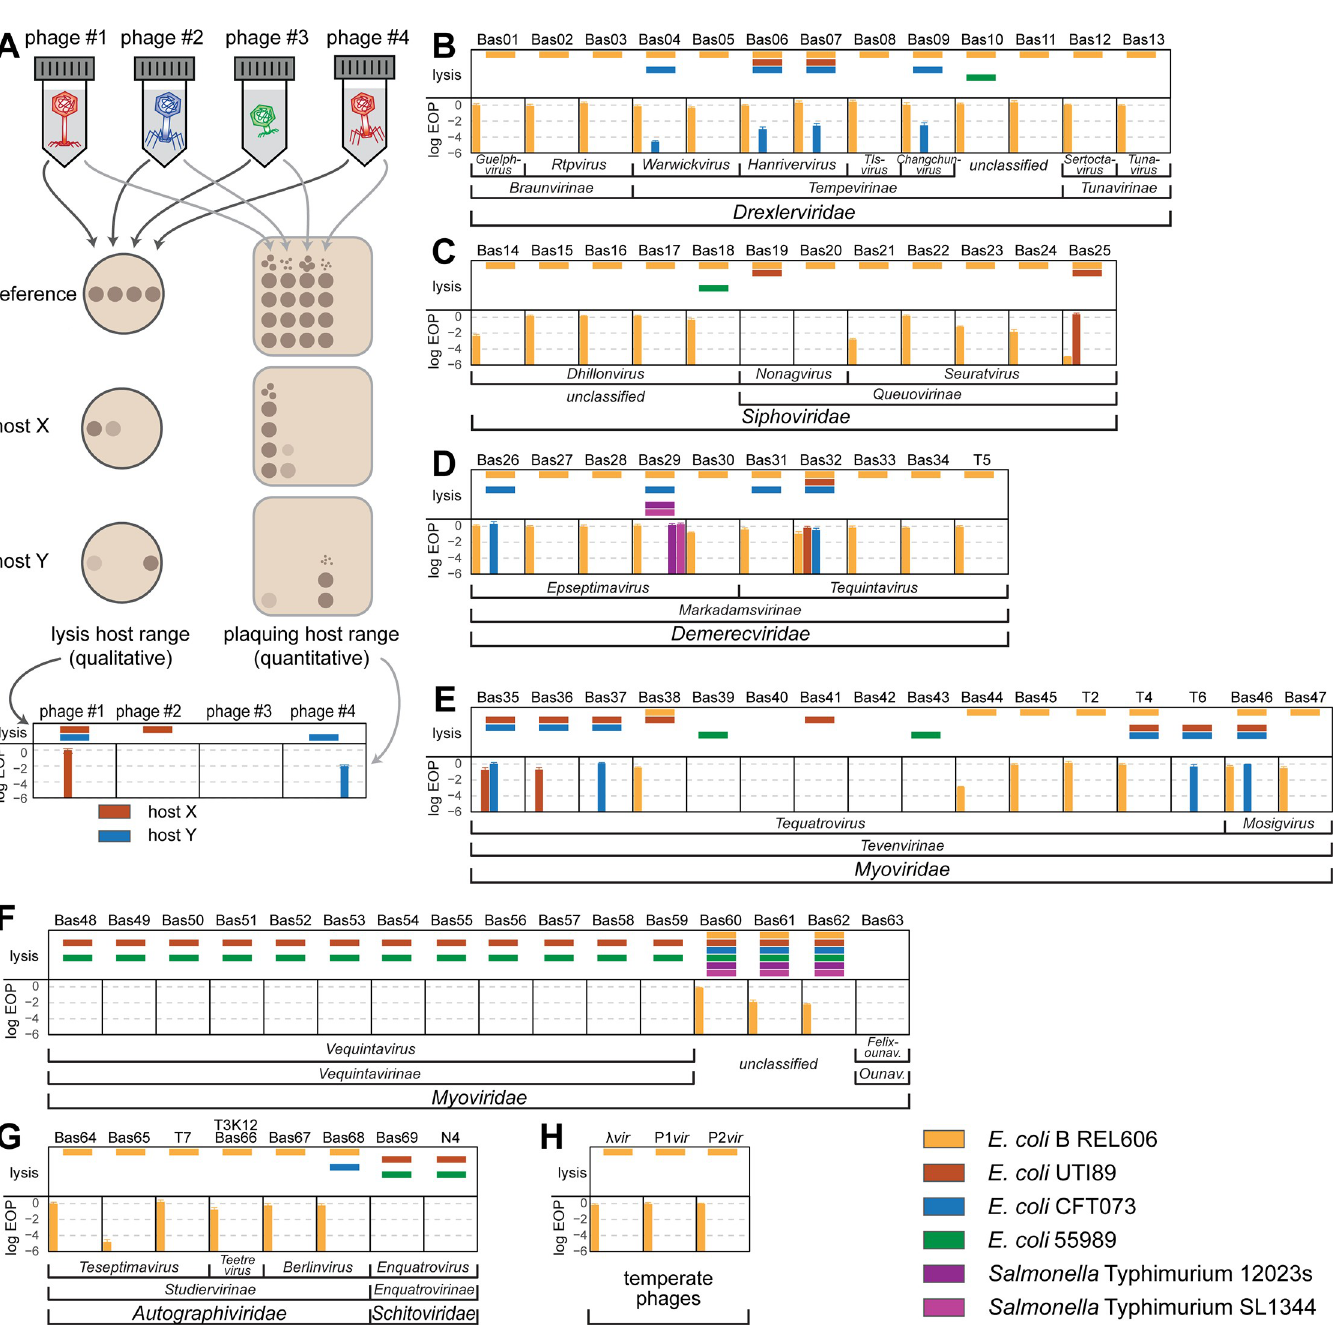
Fig 12. Host range of phages in the BASEL collection. (A) Schematic overview of qualitative spot test assays with high-titer phage stocks ( > 10 9 pfu/ml; left) and quantitative EOP assays using serial dilutions of phage stocks (right) to determine the lysis host range and the plaquing host range of bacteriophages, respectively (see Materials and methods for details of the methodology). The graph at the bottom highlights how the results of the 4 fictional phages in this example would be plotted (with colorful bars at the top indicating the lysis host range and a bar diagrams for the EOP at the bottom that shows the plaquing host range). (B-H) The lysis host range and the plaquing host range of all phages in the BASEL collection across different enterobacteria were determined and visualized as shown in (A). Data points and error bars of the EOP plots represent average and standard deviation of at least 3 independent experiments. Raw data and calculations are available in S1 Data. BASEL, BActeriophage SElection for your Laboratory; EOP, efficiency of